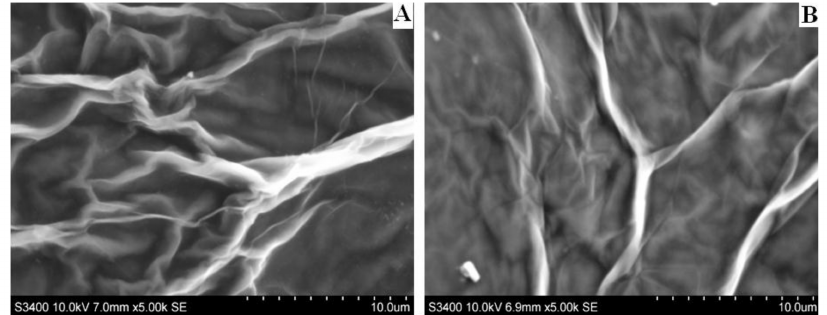
Figure 3. Scanning electron micrograph images of electrode surface—graphene oxide ( A ) and electrochemically reduced graphene oxide ( B